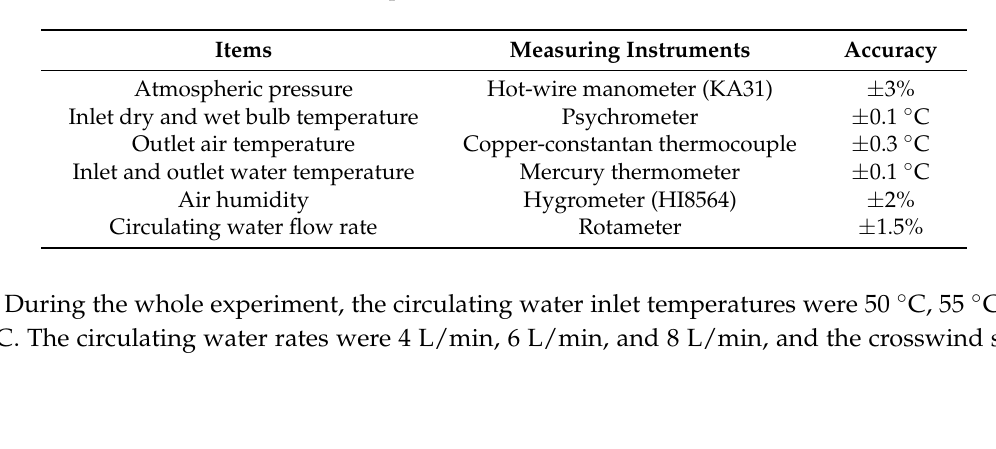
Table 1. Monitored parameters and measurement instruments.